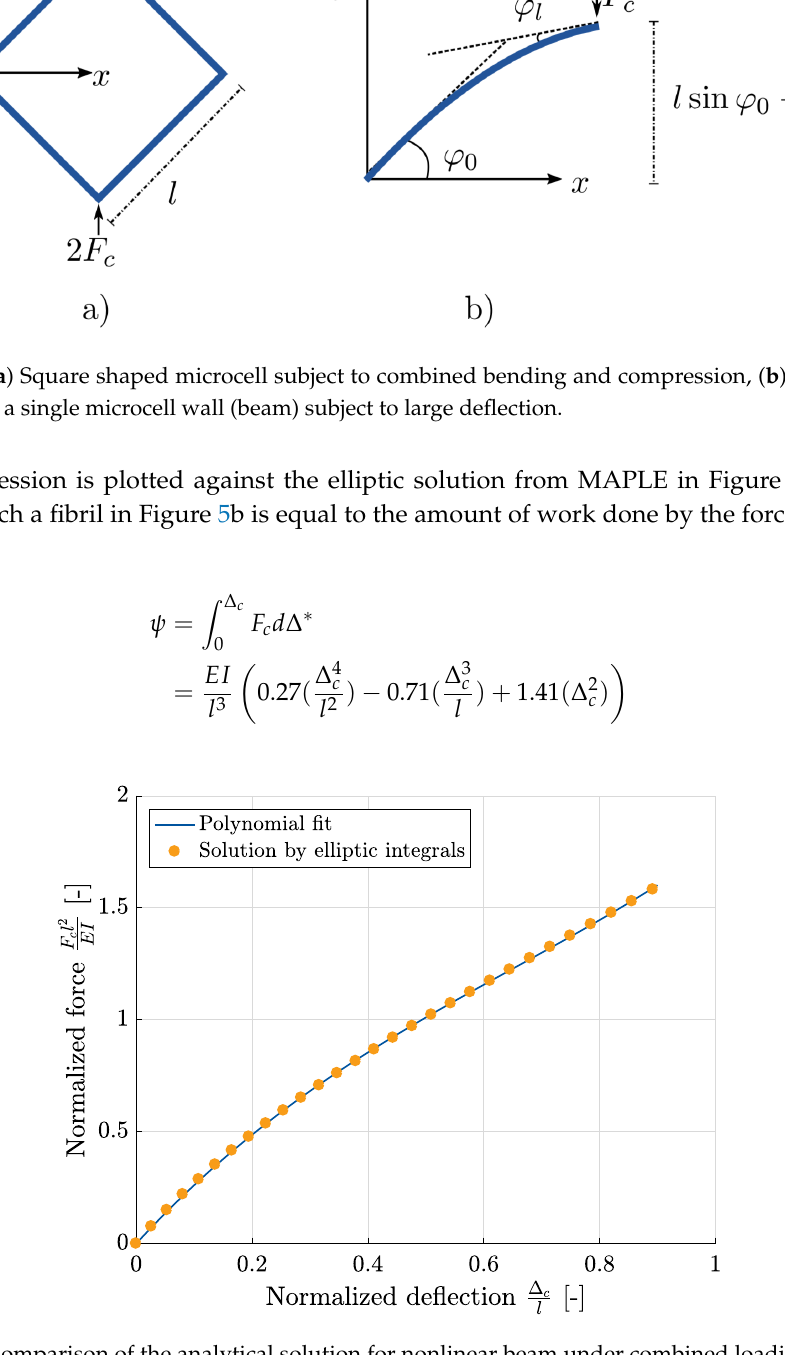
Figure 6. Comparison of the analytical solution for nonlinear beam under combined loading against the proposed polynomial